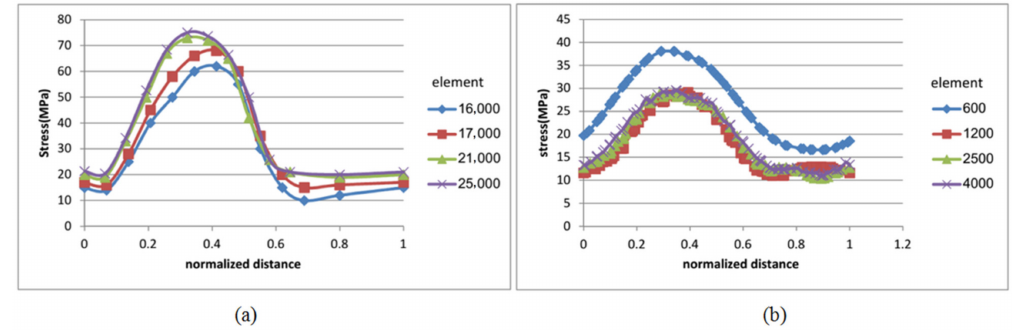
Figure 3. Von Mises stress in normalized distance (for unifying the figures the selected path for investigating Von Mises stress was inverted to scale of 0 to 1) for different sizes of the elements ( a ) in the crown and ( b ) in the framework.